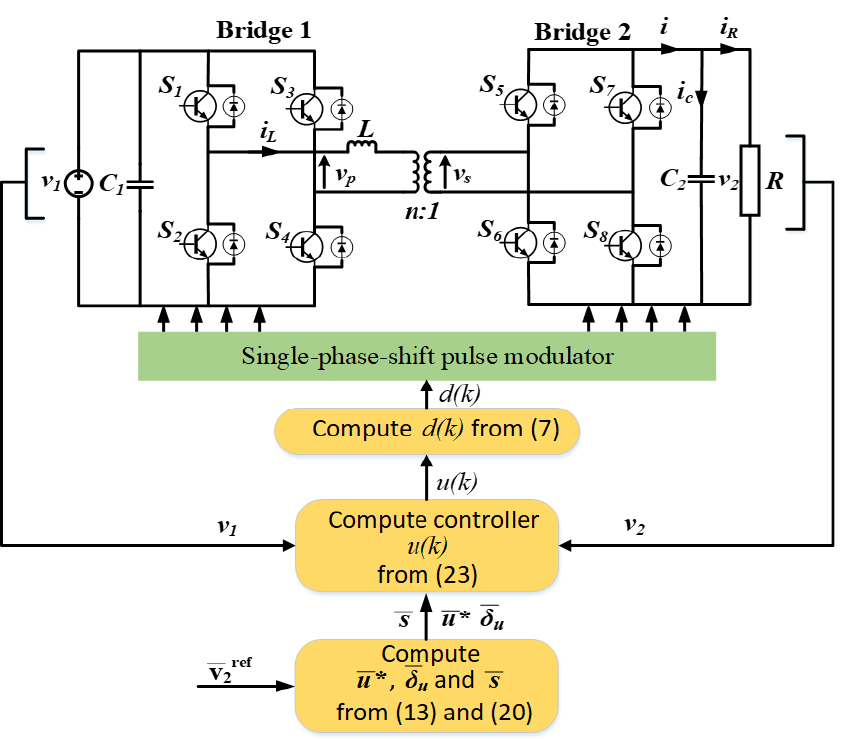
Figure 3. Block diagram of the robust control for the DAB DC–DC converter with steady-state error and input saturation.